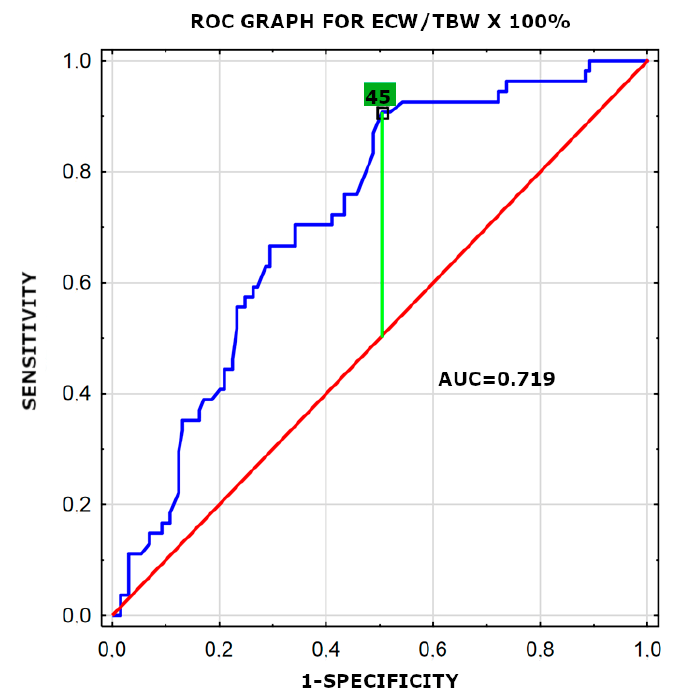
Figure 1. Receiver-operating characteristic curve (ROC) for the ECW/TBW × 100% variable revealing its diagnostic potential. AUC -area under the ROC curve.